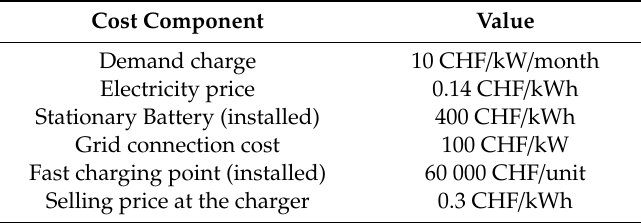
Figure 10. Required ESS capacity as a function of the available grid connection for 450 charging events per week. Table 3. Economic parameters for business case